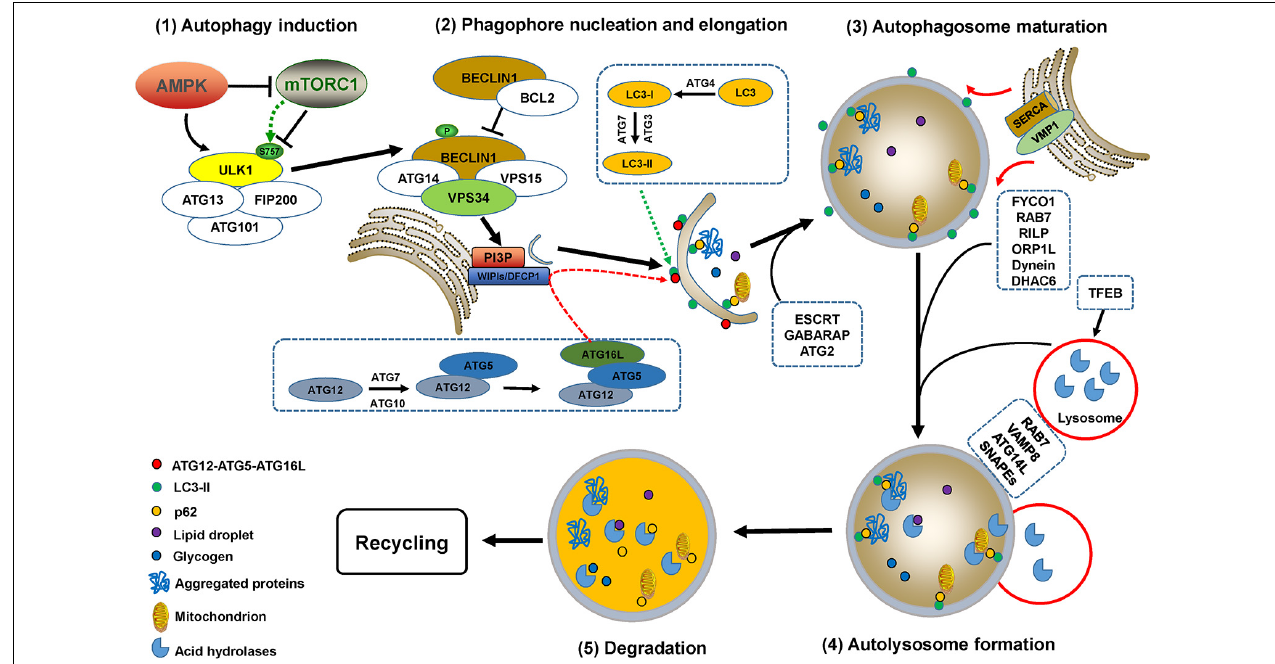
FIGURE 2 | The processes of autophagy. Autophagy processes include autophagy induction, phagophore nucleation, elongation and closure, autophagosome maturation, and fusion with lysosomes to form autolysosomes, which are mediated by multiple ATG proteins and a variety of kinases or partners with complex mechanisms. Autophagy initiation requires the activation of the uncoordinated-51-like kinase (ULK) complex, which is regulated by two kinases, AMP-activated protein kinase (AMPK) and mammalian target of rapamycin (mTOR) complex 1 (mTORC1). ULK1 activation causes phosphorylation of BECLIN1 and ATG14, thus promoting the formation of the PI3KC3 complex, which enhances the activity of VPS34 to generate phosphatidylinositol 3-phosphate (PI3P) (Russell et al., 2013; Nascimbeni et al., 2017). The enrichment of PI3P recruits double FYVE domain-containing protein 1 (DFCP1), downstream ATG proteins, and WD repeat proteins interacting with phosphoinositides 1 and 2 (WIPI1/2) for phagophore nucleation (Young and Wang, 2018). Phagophore elongation is mediated by two ubiquitin-like conjugation systems, ATG12-ATG5-ATG16L and the ATG8 (light chain 3, LC3) conjugation system (Noda and Inagaki, 2015). Phagophore closure is most likely accomplished by endosomal sorting complex required for transport (ESCRT) machinery-mediated membrane abscission (Tsuboyama et al., 2016; Takahashi et al., 2018, 2019). Additionally, the γ -aminobutyric acid receptor-associated protein (GABARAP) and ATG2 family are also critical for phagophore closure (Weidberg et al., 2010; Bozic et al., 2020). The ER-localized transmembrane protein vacuole membrane protein 1 (VMP1) mediates ER-phagophore dissociation via activating ER Ca 2 + channel sarcoplasmic Ca 2 + -ATPase (SERCA) and perturbing the local Ca 2 + concentration (Zhao et al., 2017). Mature autophagosomes migrate to lysosomes involves the participation of proteins such as RAB7, FYVE coiled-coil domain-containing protein 1 (FYCO1), RAB-interacting lysosomal protein (RILP), Oxysterol-binding protein-related protein 1L (ORP1L), histone deacetylase 6 (HDAC6), kinesin or dynein (Nakamura and Yoshimori, 2017). RAB GTPases, soluble N -ethylmaleimide-sensitive factor attachment protein receptors (SNAREs), PI3K complex, and multiple tethering factors are involved in the fusion of autophagosomes with lysosomes to form autolysosomes, in which the autophagosomal contents are degraded by lysosomal acid hydrolases (Martini-Stoica et al., 2016; Zhao and Zhang, 2019). Transcription factor EB (TFEB) is a major regulator for autophagosome formation, lysosomal biogenesis, and lysosomal function (Martini-Stoica et al., 2016; Cortes and La Spada,